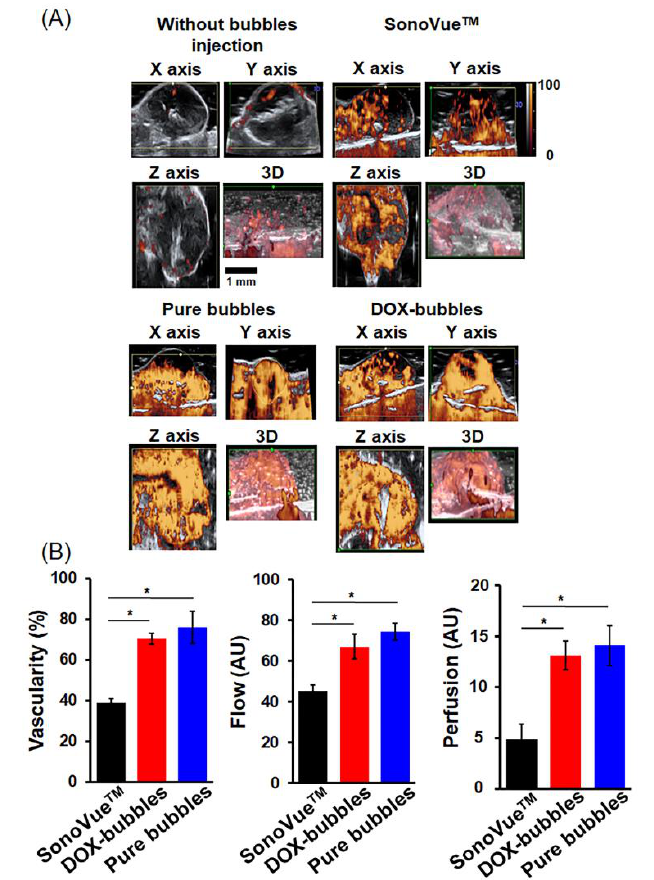
Figure 6. ( A ) The Doppler ultrasound images of osteosarcoma tumor model. Three groups were involved, without bubbles injection, SonoVue TM , pure bubbles, and DOX-bubbles. Note that the scale bar was for all the sub-figures. ( B ) Left: vascularity index (VI), denotes the ratio of color-coded voxels to all voxels of the tumor region; middle: flow index (FI), denotes the mean value of all color-coded voxels in the vessels of the volume analyzed; right: perfusion index (PI), denotes the mean value of voxels within the tumor region. These results suggested that compared with the SonoVue TM , DOX-bubbles showed better microcirculation enhancement. Single asterisk, p < 0.05.